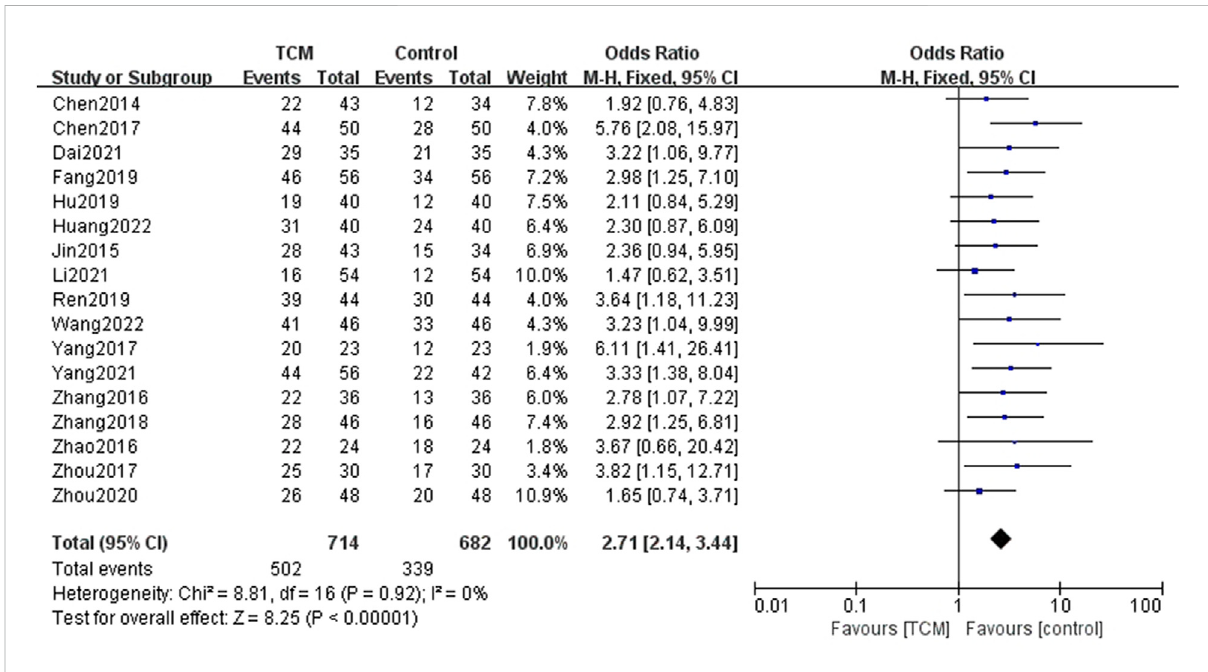
FIGURE 4 Forest plots for comparison of ORR between TCM group and control group.